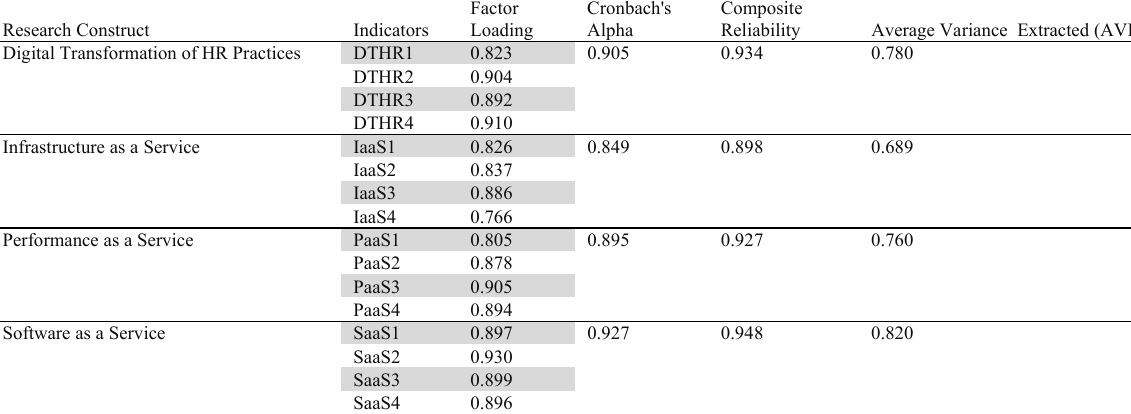
Convergent Validity, Composite Reliability and Cronbach's Alpha Research